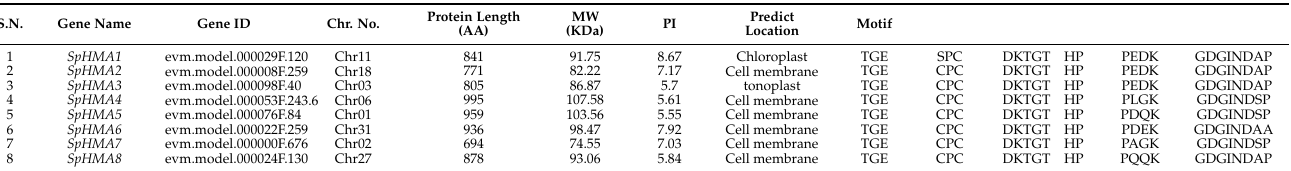
Table 1. Characteristics of 8 SpHMAs identified in S. plumbizincicola .